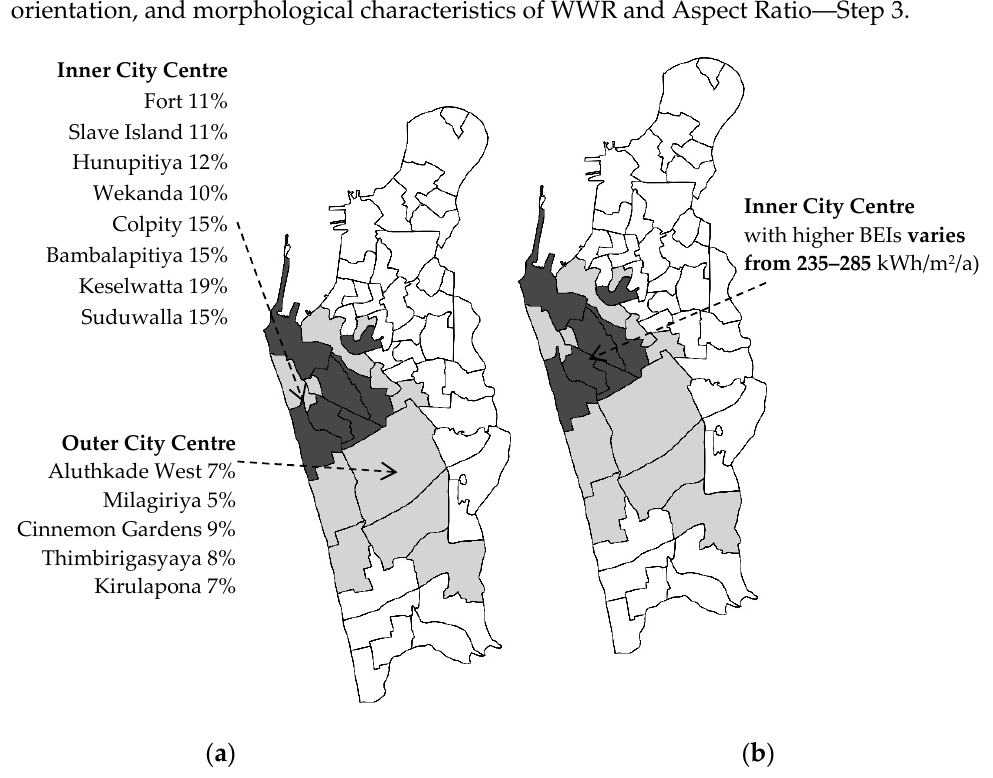
Figure 3. Map of Colombo Metropolitan Region showing ( a ) dispersion of the office building stock and ( b ) an inner city center with buildings with higher Building Energy Indices (BEIs).